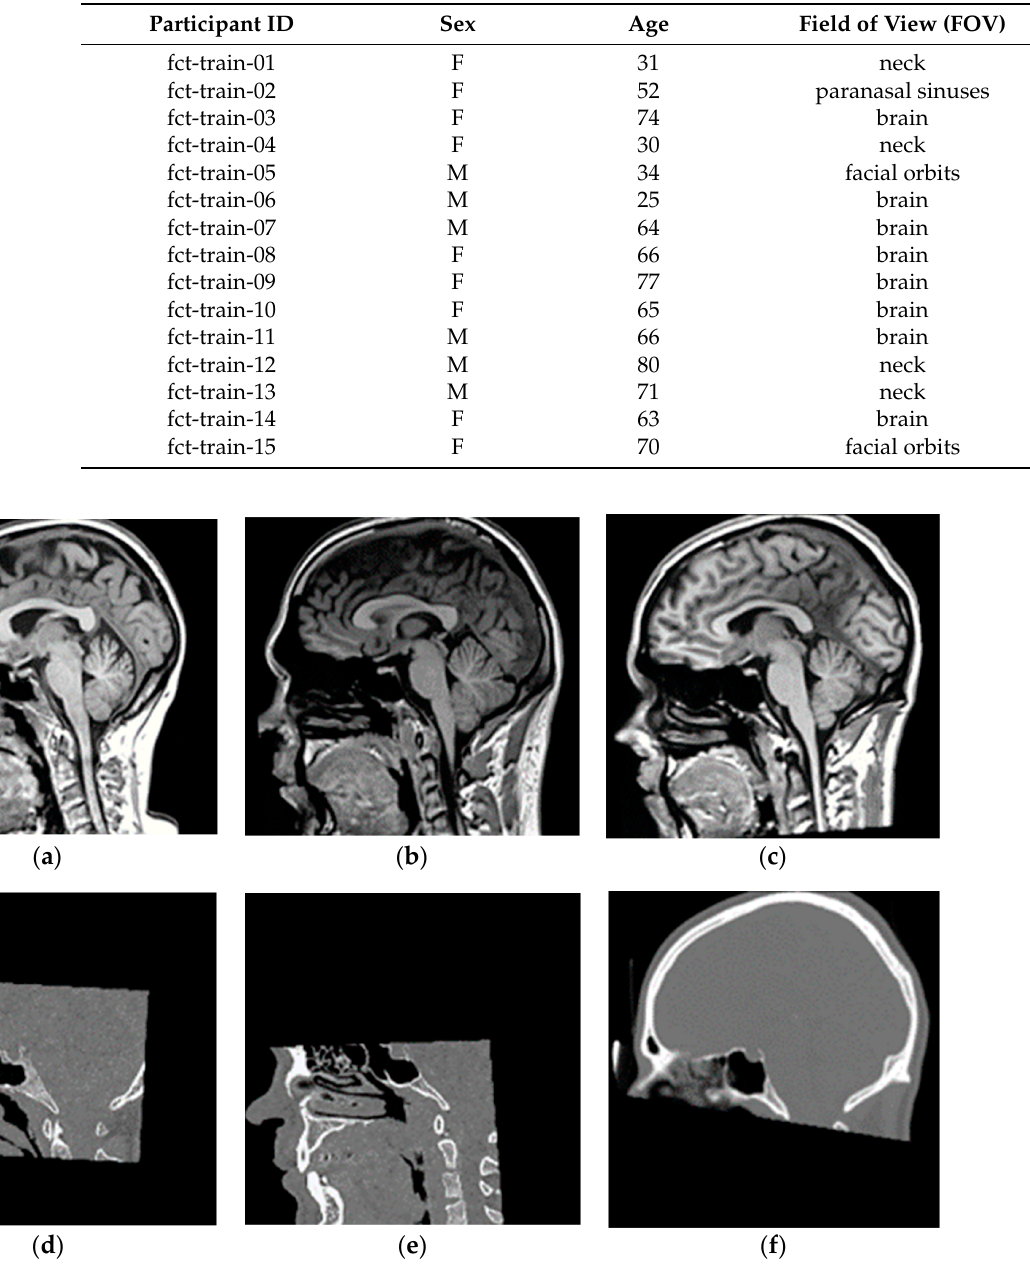
Table 1. Demographic and technical details from patients included in the training dataset.